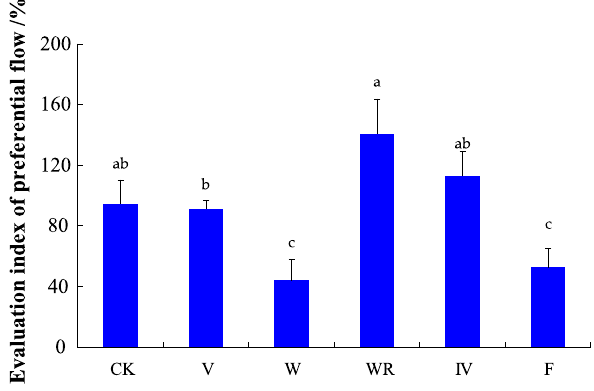
Fig. 5 Evaluation index of preferential flow for the different near- surface fissures. (CK) no fissures, (V) V-type fissure, (W) W-type fis- sure, (WR) W + rocks-type fissure, (IV) inclined V-type fissure, (F) conduit fissure